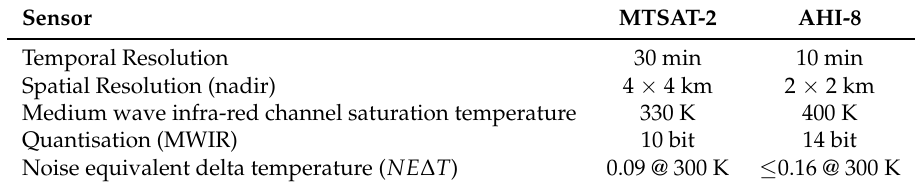
Table 1. Comparison of MTSAT-2 and AHI-8 sensors for fire detection using a MWIR ( ∼ 4 µ m) channel.